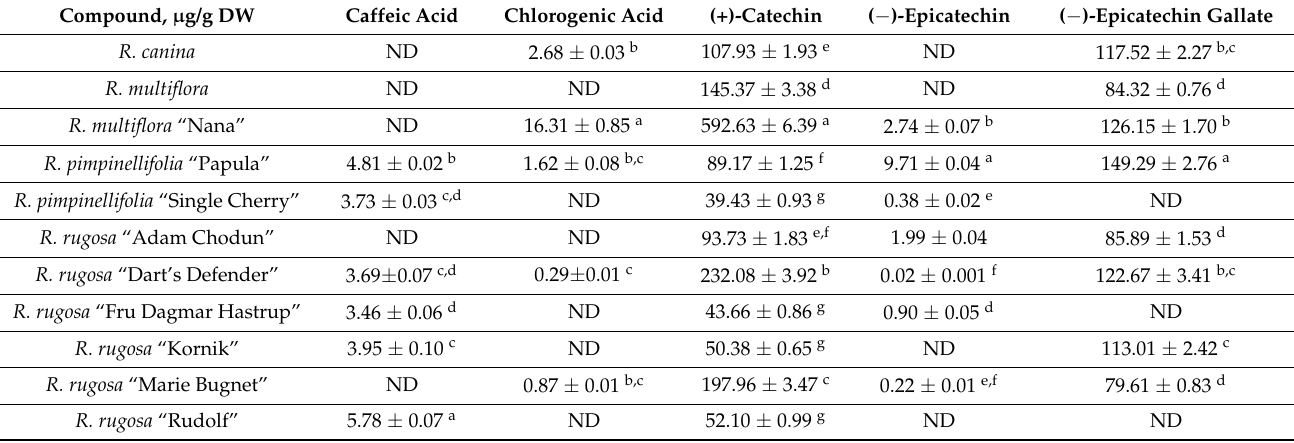
Table 2. Variability of the quantitative composition of phenolic acids and flavan-3-ols in Rosa L. fruit samples Compound, µ g/g